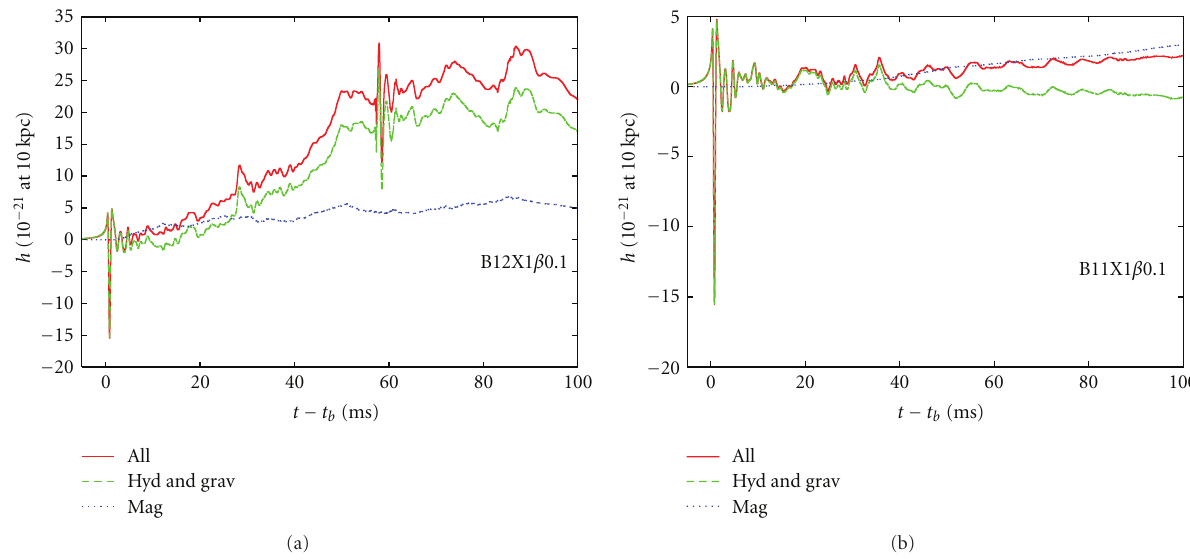
Figure 22: Gravitational waveforms with an increasing trend (left) or not (right panel). Initial rotation parameter is set to be β = 0 . 1%, while the precollapse magnetic field is taken as 10 12 G (left panel) and 10 11 G (right panel), respectively (from [219]). The total wave amplitudes are shown by the red line, while the contribution from the magnetic fields and from the sum of hydrodynamic and gravitational parts are shown by blue and green lines, respectively (e.g., (14) and (11), (13)). Note that the bounce GW signals (( t − t b (cid:3) 20ms) are not a ff ected by the magnetic fields significantly, and they are categorized into the so-called type I or II